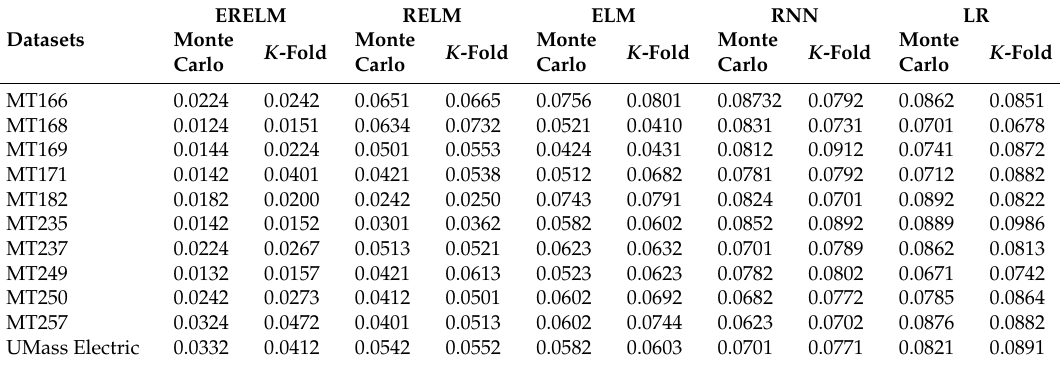
Table 11. Obtained RMSE for yearly testing data using ELM, RELM and ERELM by Monte Carlo and K -Fold cross validation.